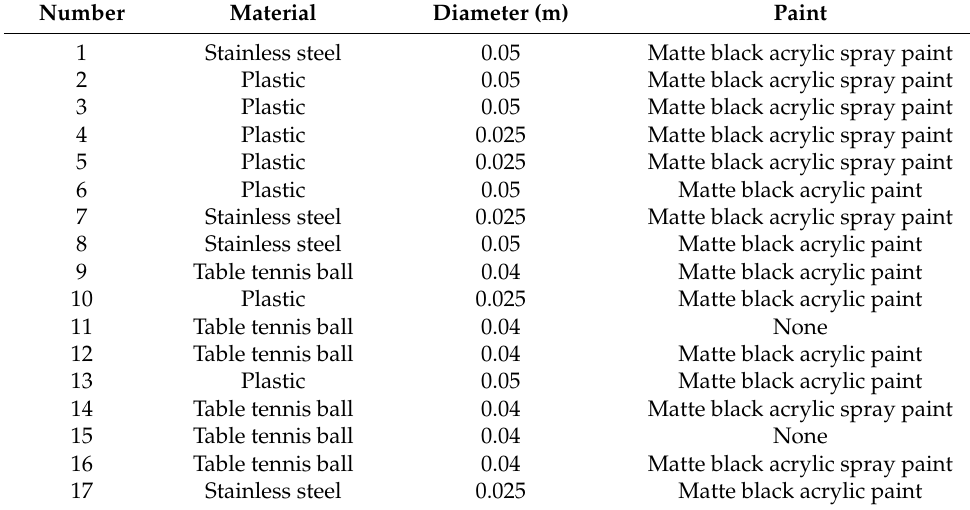
Table A3. Different globes tested for the determination of globe temperature ( T g